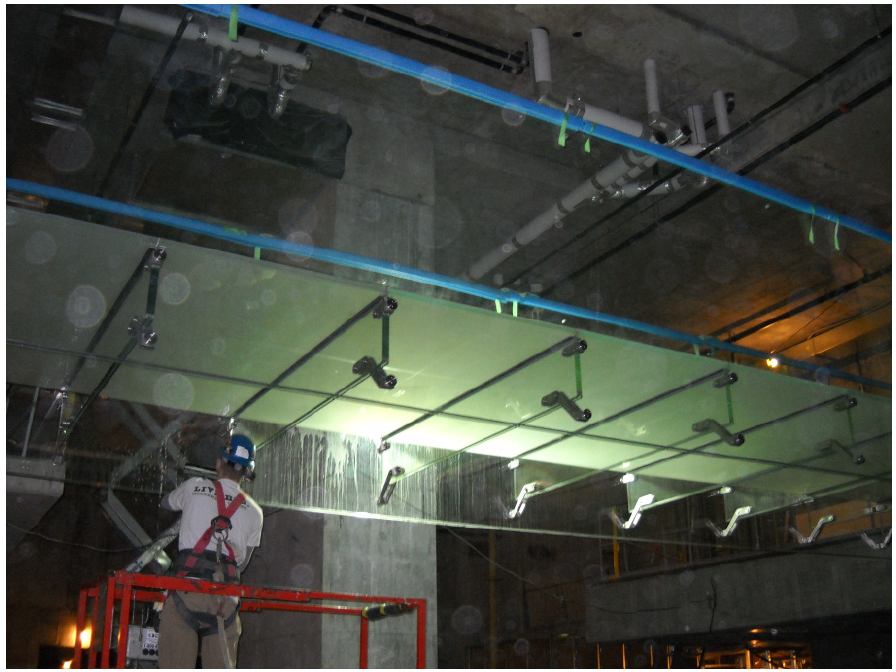
Figure 11: Installation in the Ritz Carlton